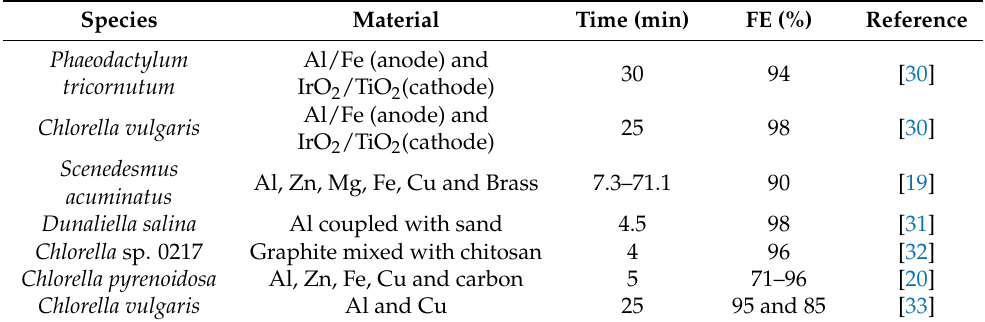
Table 3. An overview of recent studies on electrodes other than Al or Fe utilized for microalgae harvesting.